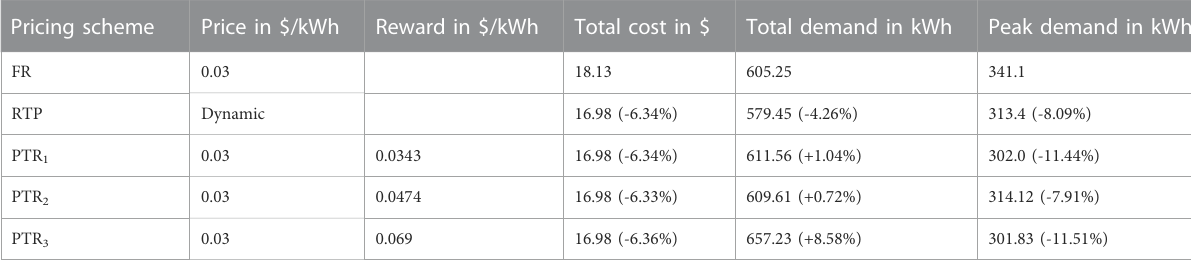
TABLE 8 Equal loss scenario. Pricing